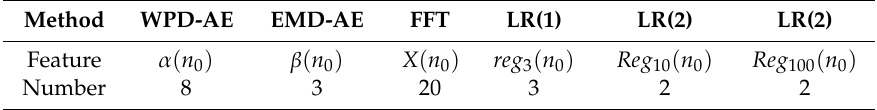
Table 2. MFE feature for each group data. EMD ‐ AE: Empirical Mode Decomposition ‐ approximate Table 1. MFE feature for each group data. EMD-AE: Empirical Mode Decomposition-approximate entropy feature; FFT: fast Fourier transform feature; LR: linear regression feature; WPD ‐ AE: wavelet